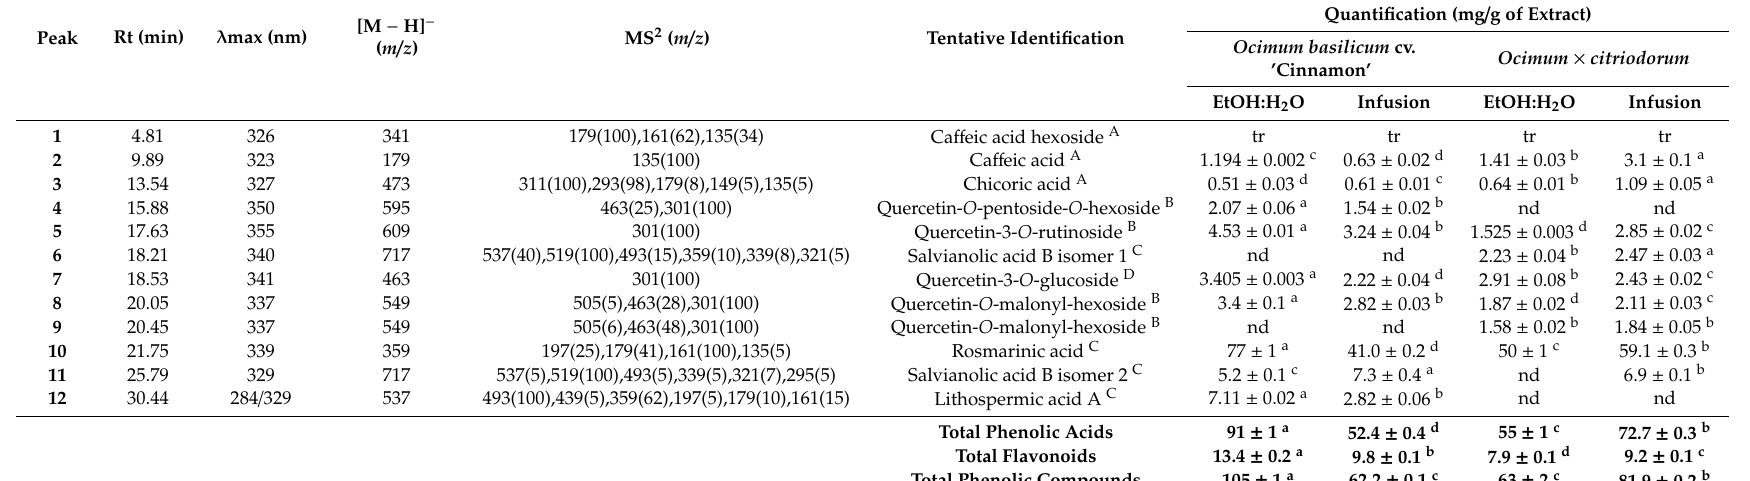
Table 1. Retention time (Rt), wavelengths of maximum absorption in the visible region ( λ max), mass spectrometric data, tentative identification, and quantification (mg / g of extract) of the phenolic compounds in Ocimum basilicum ’Cinnamon’ and Ocimum × citriodorum hydroethanolic extracts and infusion preparations.